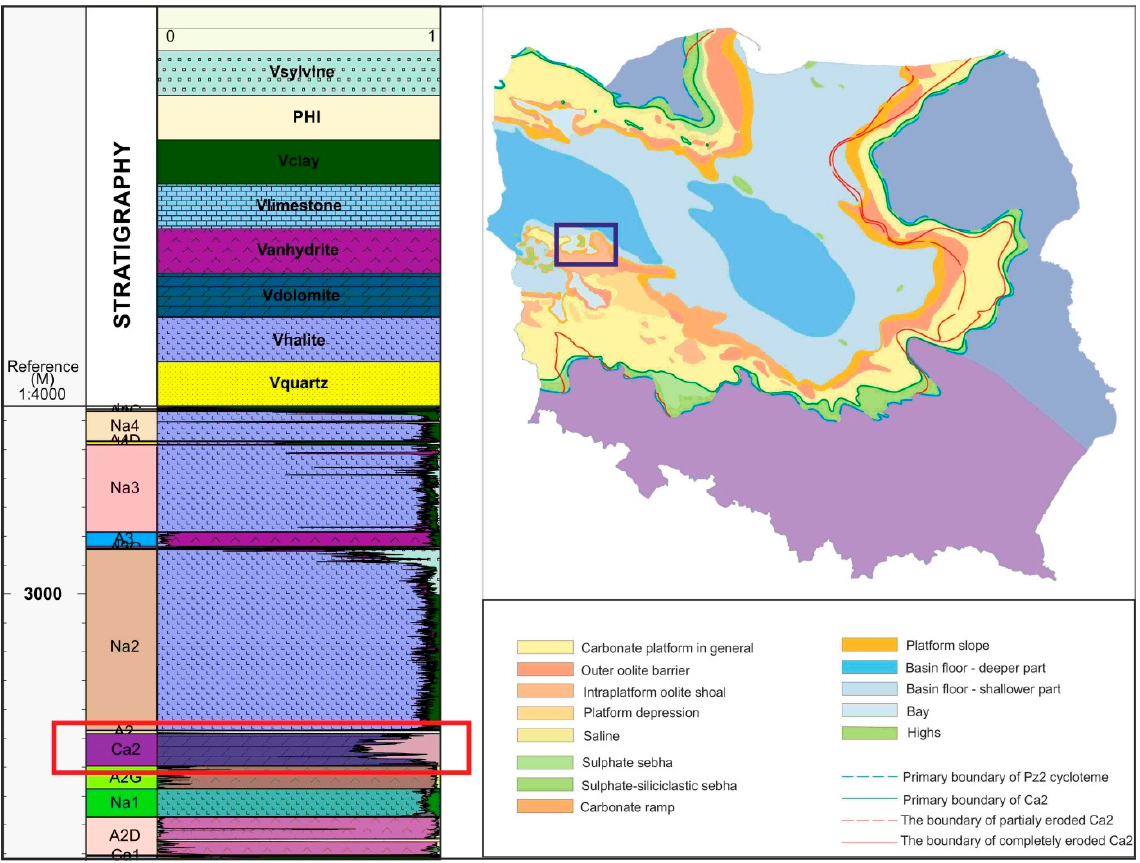
Figure 1. Lithostratigraphic profile in the reference borehole ( left ) and the location of the study area on the background of the map of the main dolomite (Ca2) in Poland ( right ) [24].